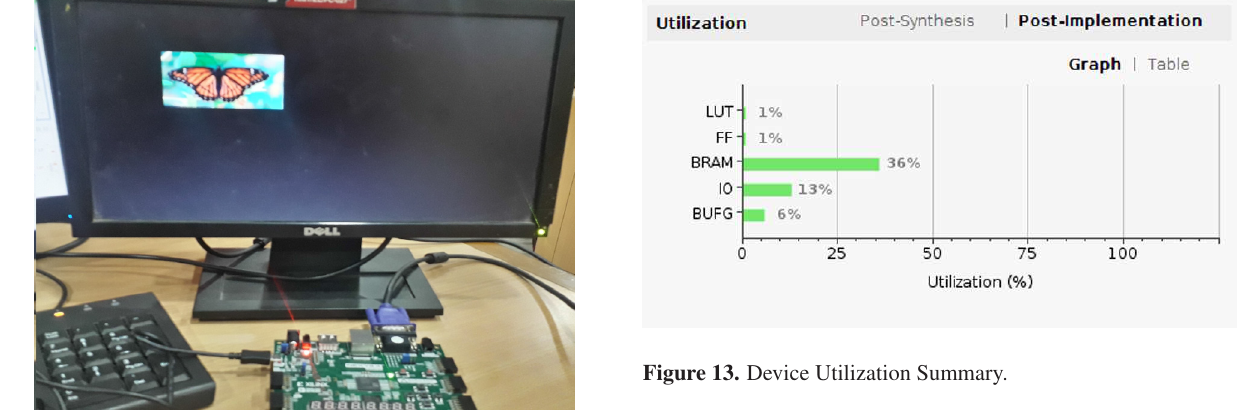
Figure 13. Device Utilization